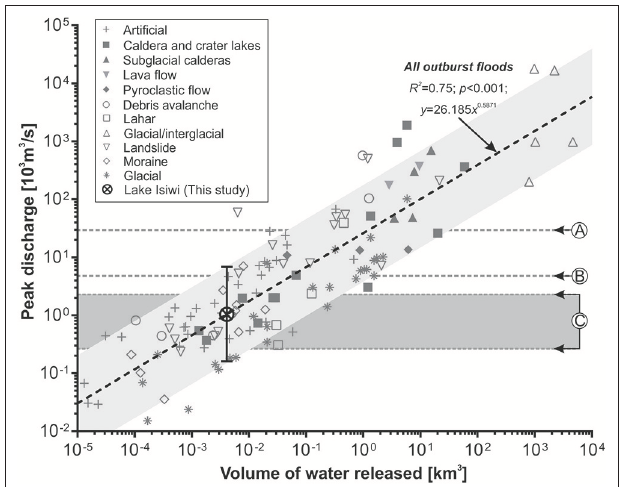
FIGURE 11 | Plot of peak discharge in relation to volume of water released from outburst floods based on global data from Manville (2010; reproduced under Copyright License 4433040862707. Black dashed lined is power-law trend for all outburst floods, and light gray parallel fill is the 99th percentile range. Lettered annotations refer to peak river discharges for: (A) Gaoping River following Typhoon Morakot in 2009 [28,000 m 3 /s; ( Carter et al., 2014)] when hyperpycnal flow triggered a turbidity current; (B) highest recorded river discharge in New Caledonia on Grand Terre due to Cyclone Anne in 1988 [4,583 m 3 /s; (Terry et al., 2008)]; and ( C and dark gray fill) the range of discharge on the Squamish River, British Columbia when turbidity currents are known to occur Clare et al. (2016). The estimated discharge for the 2,000 Lake Isiwi outburst flood is ∼ 1,000 m 3 /s, with an upper bound estimate